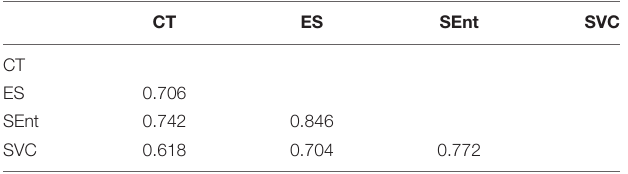
TABLE 6 | Heterotrait-monotrait ratio of correlations